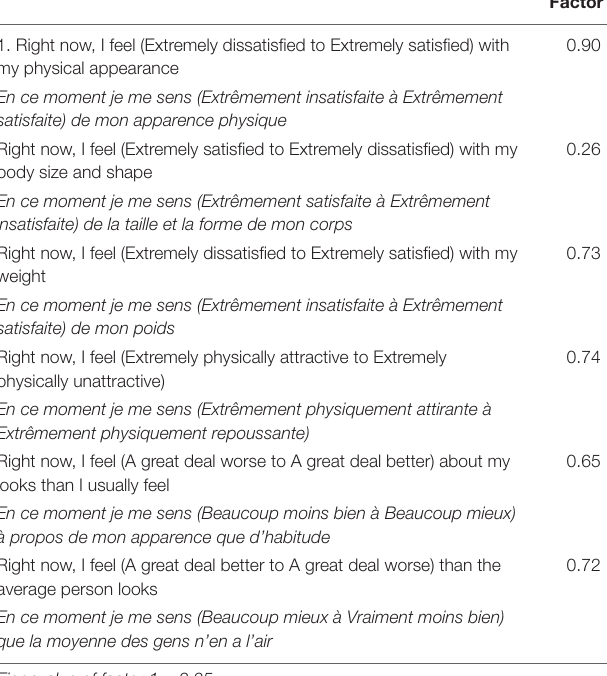
TABLE 1 | Exploratory factor analysis of the F-BISS.